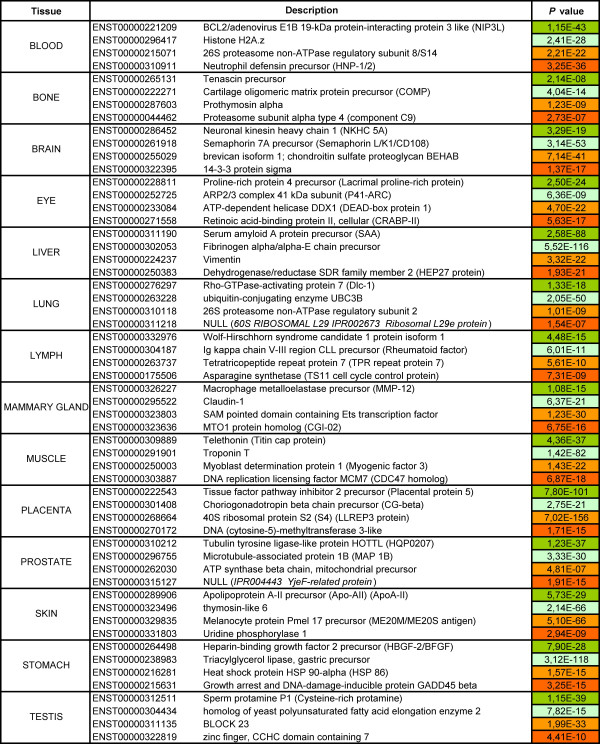
Genes whose transcripts exhibited tissue-specific differential expression in normal versus tumor libraries. This figure is a compilation of genes that appear to be differentially expressed in only one of the 15 studied tissues. The results are shown for fourteen tissues. The color code is the same as in Figure 1. See additional information for the full data.